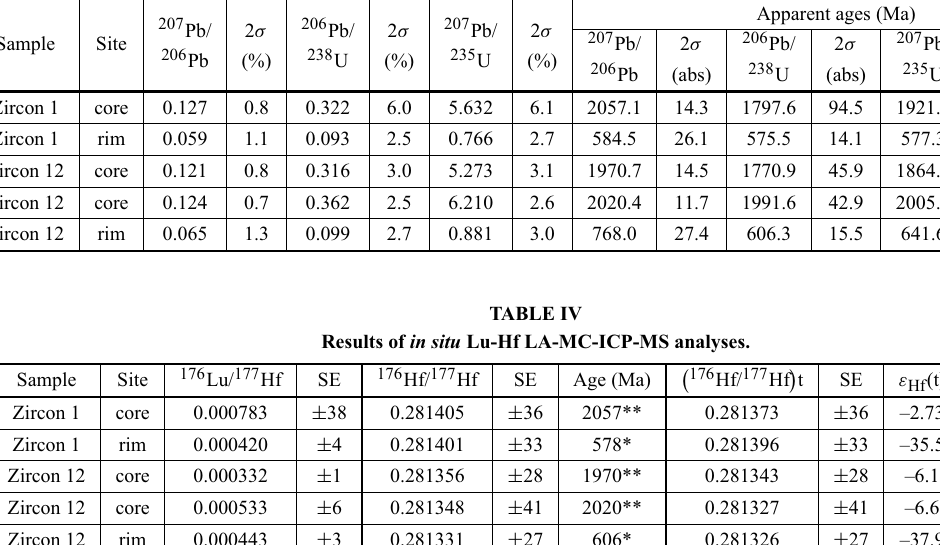
Apparent ages (Ma)